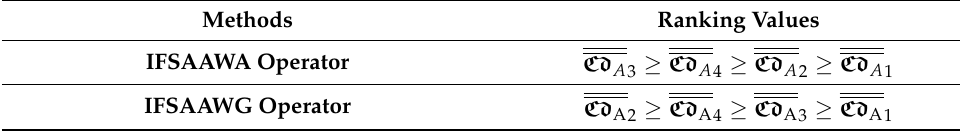
Table 7. Mathematical representation of ranking